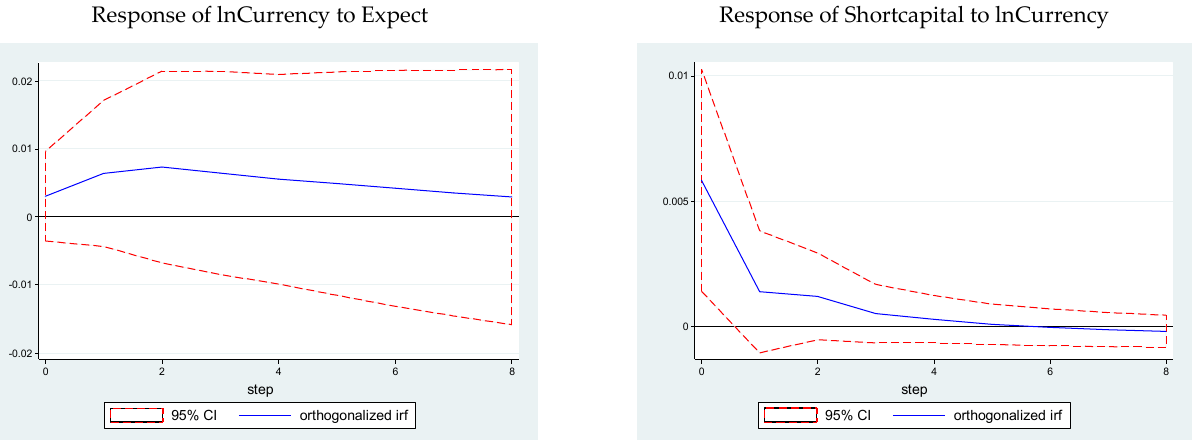
Figure 5. Impulse Response of lnCurrency to Expect and Shortcapital to lnCurrency.